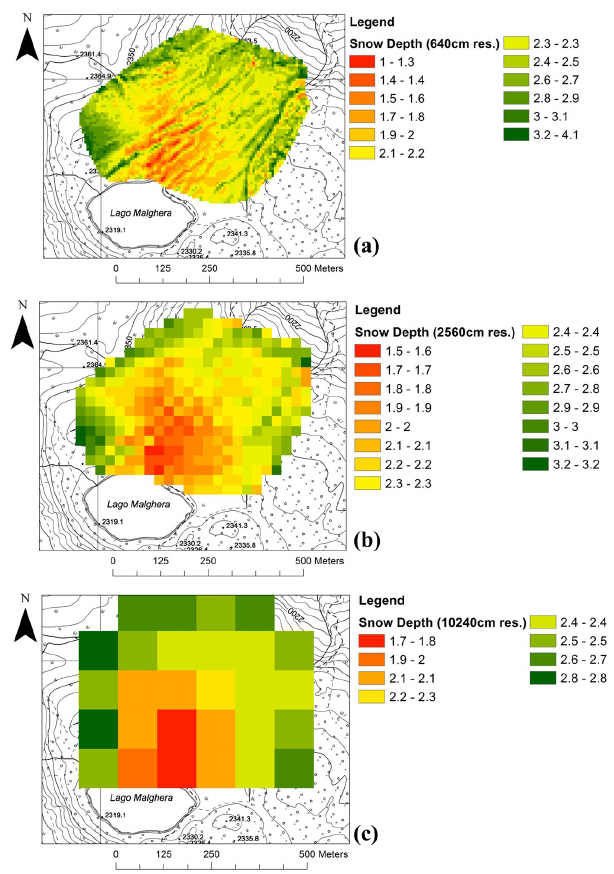
Figure 8. Rescaled maps of snow depth (in m) at different cell sizes. (a) 640cm, (b) 2560cm, (c) 10240cm. See Sect. 4.3.2 for details.